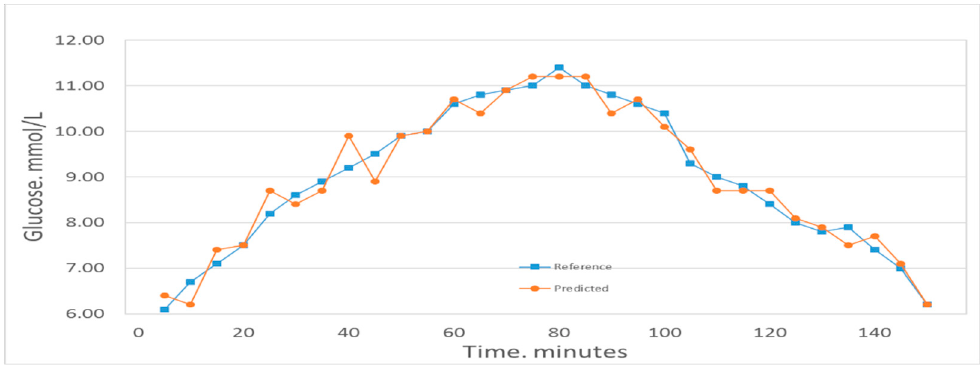
Figure 5. Predicted glucose concentrations tracking the reference values for one